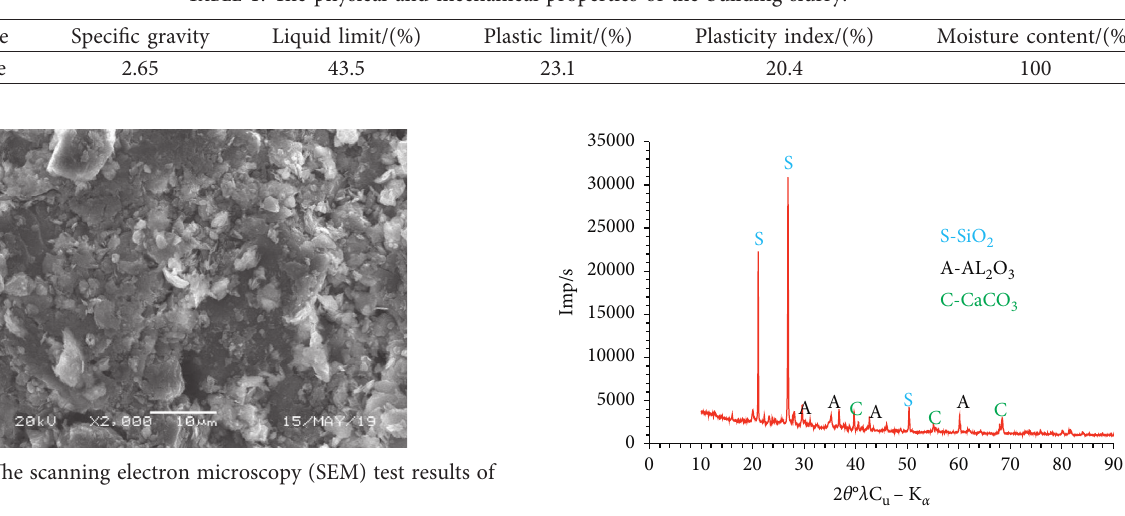
Figure 4: The X-ray diffraction (XRD) test results of the slurry. Table 2: The unconfined compressive strength (UCS) test